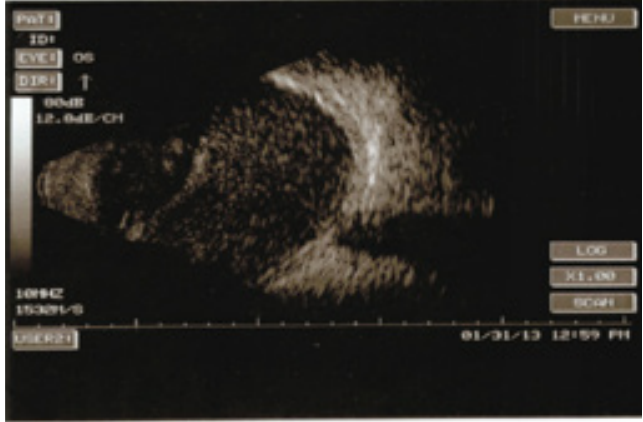
Figure 1: Showing vitreous haemorrhage and endophthalmitis in the left eye. Visual acuity was